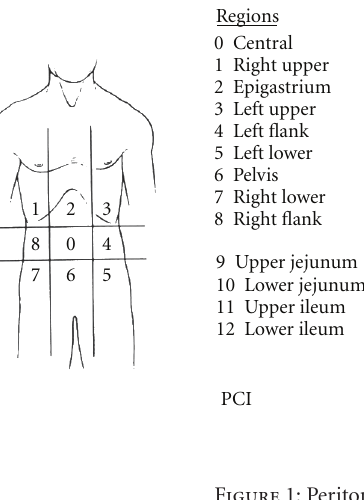
Figure 1: Peritoneal cancer